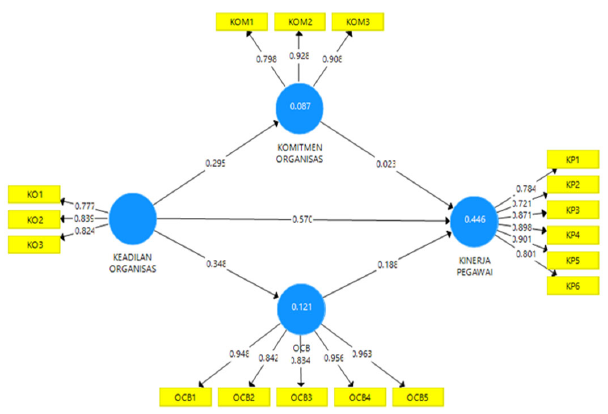
Fig. 2. Research Model Path Sources: SmarPLS 3.3 Programs